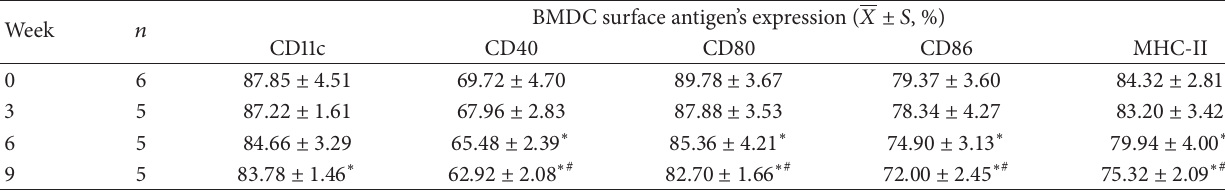
Table 4: BMDC surface antigen’s expression of CTX group.